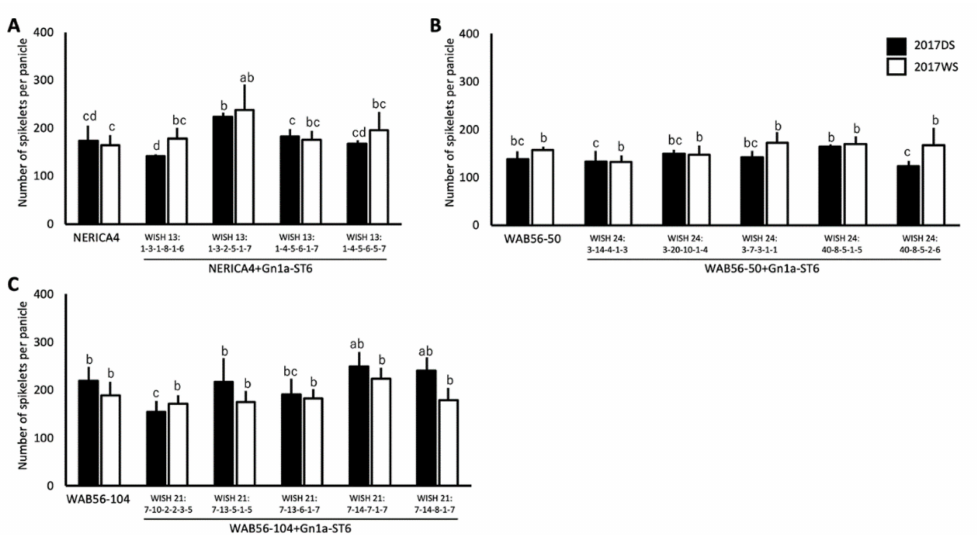
Figure 4. Number of spikelets per panicle (mean ± SD) of Gn1a-ST6 introgression lines in the genetic backgrounds of NERICA4 ( A ), WAB56-50 ( B ), and WAB56-104 ( C ). Solid and white bars show the results in 2017DS and 2017WS, respectively. Different letters above the bar graphs indicate significant difference at p <